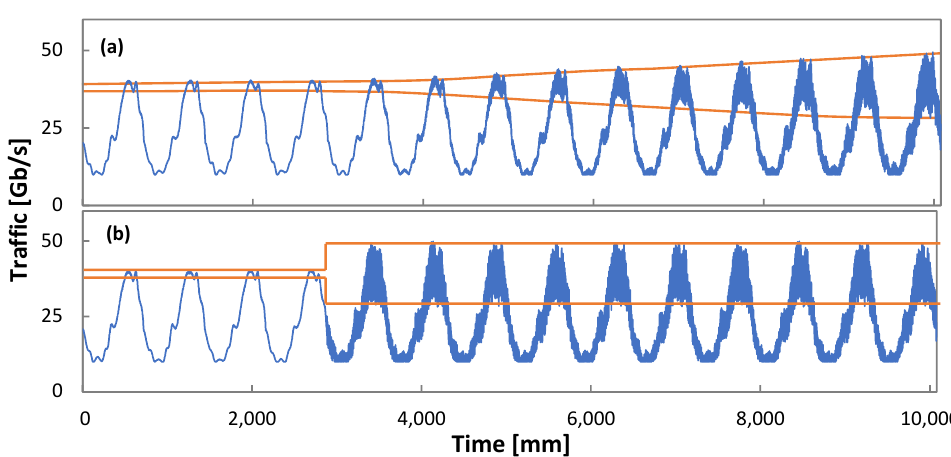
Figure 16 . Phase III: Traffic variance change scenarios. Gradual increase ( a ) and sudden increase ( b ). Table 4 details the time to detect the traffic change when the variance range was configured as [ var_l , var_h ] = [ − 10%, +10%]; the current traffic variance and minimum reward rw_l was set to 5% of the minimum observed reward (see Algorithm 6). We observe that the proposed mechanism ensures prompt reaction under any of the studied changes—immediate detection is achieved when a sudden change happens, and no more than one hour is required for gradual change detection. Table 4. Phase III: Analysis under traffic